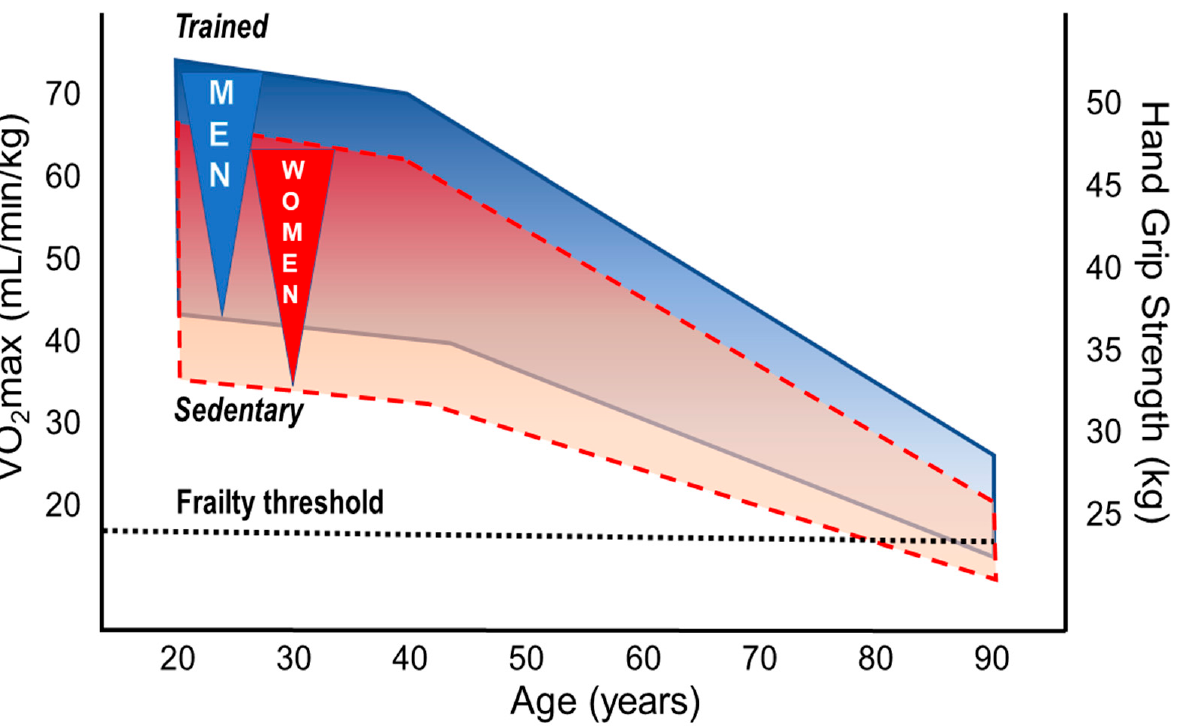
Figure 3. Schematic presentation of the age-related performance decline, i.e., in aerobic capacity (VO 2 max) and maximal grip strength, for both sexes, depending on physical training status, ranging from well-trained to sedentary. The figure is based on the meta-analysis from Fitzgerald et al. (1997) [130], with contributions from Burtscher et al. (2008) [28], Booth et al. (2010) [131], Landi et al. (2017) [132], and (defining frailty threshold as VO 2 max of 18 mL/min/kg) Carr et al. (2006) [133].